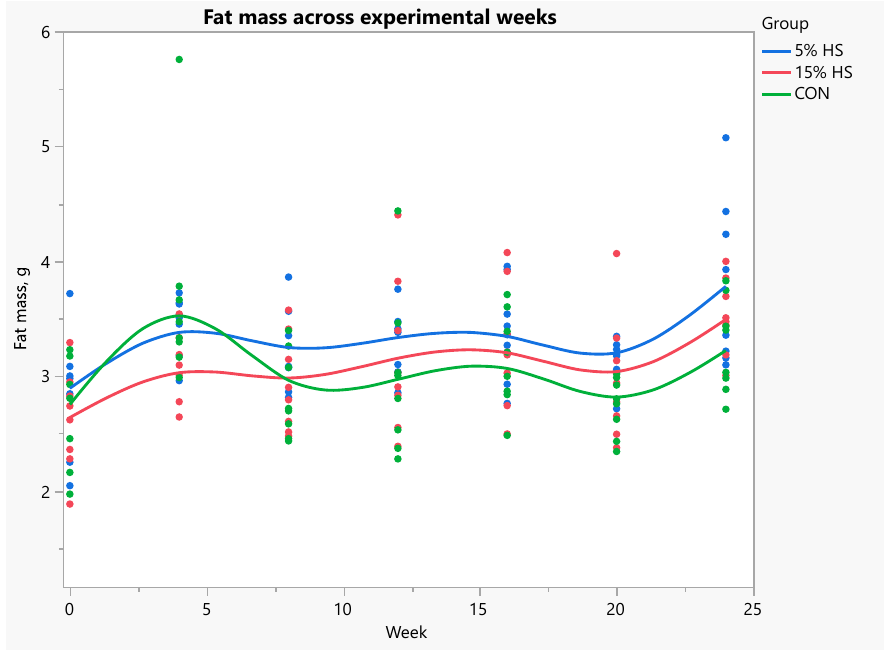
Figure 7. Fat mass (g) across experimental weeks. Measurements obtained by dual-energy X-ray absorptiometry in live mice. N = 8 per group. Each dot represents an individual mouse; colors represent the experimental diet group. Mixed models with repeated measures showed significantly higher fat mass in the 5% HS versus control diet group ( p = 0.02). Effect of week, p = 0.002.